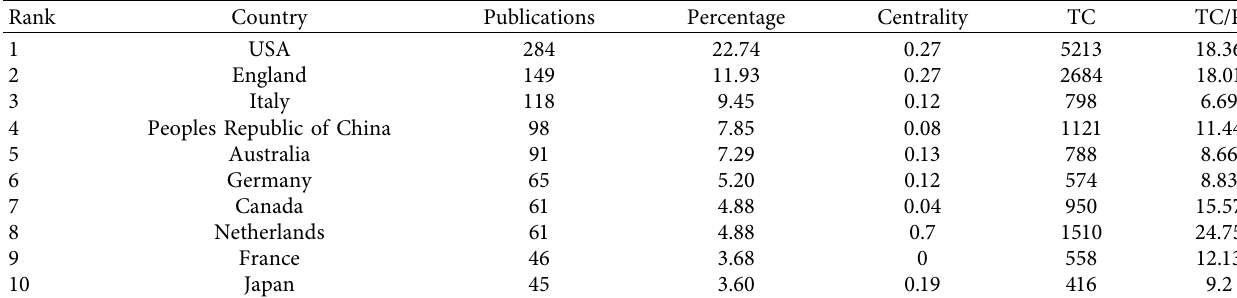
Table 2: Top 10 countries according to publications.